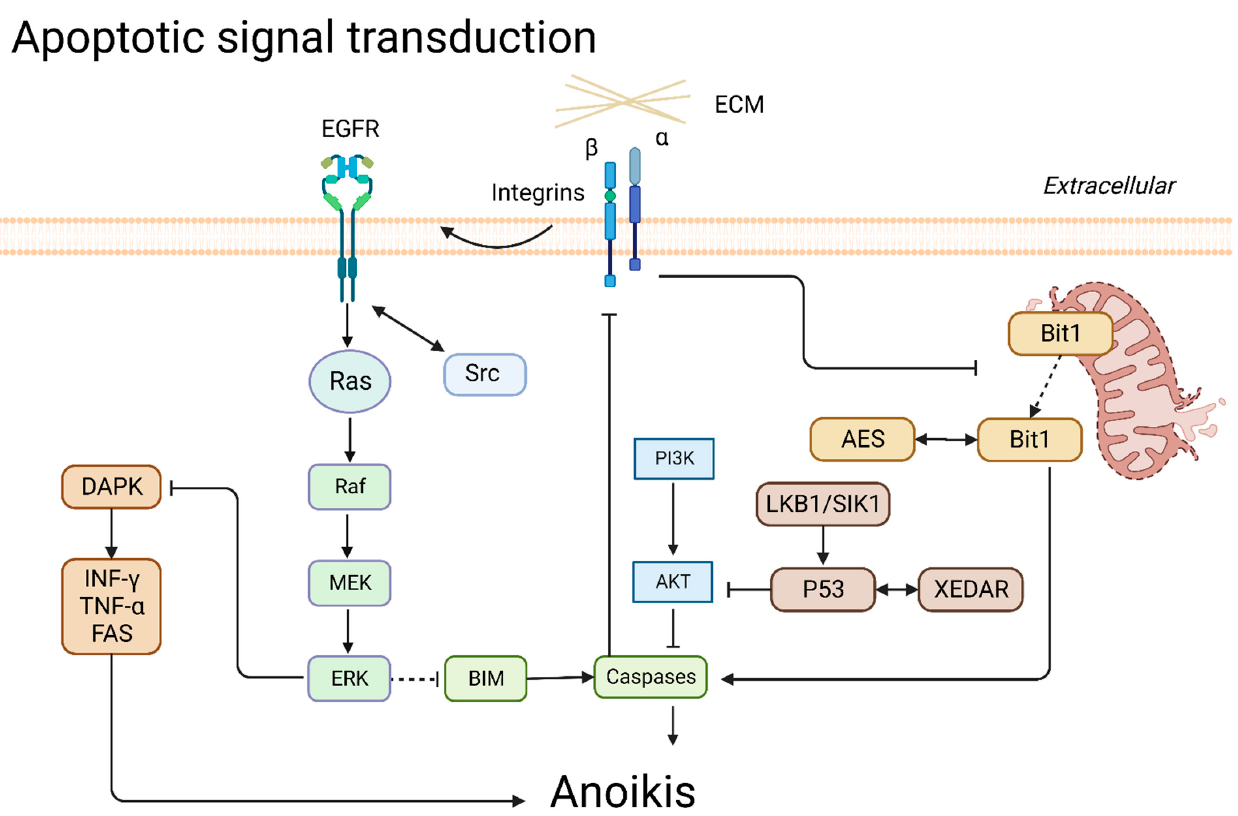
Figure 5. Apoptotic signal transduction in anoikis.